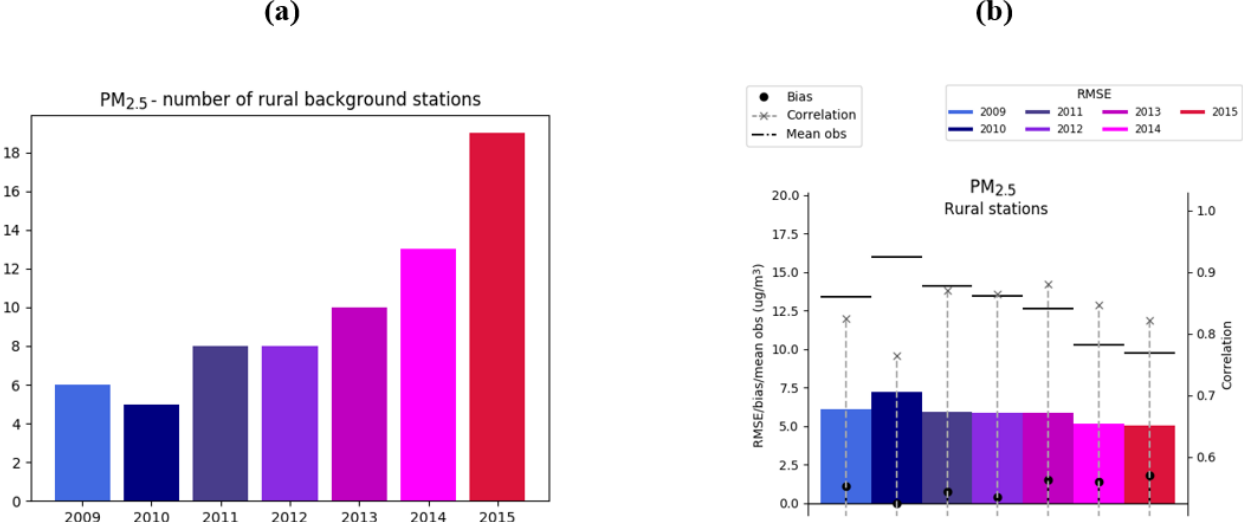
Figure 3. PM 2 . 5 : statistical indicators calculated using cross-validation technique on daily mean PM 2 . 5 values measured and estimated over rural background stations for the years 2009 to 2015. (a) Number of rural stations for each year. (b) Bias (black circles), RMSE (colored rectangles), correlation (grey crosses and the associated dashed lines) and mean observation (horizontal lines).